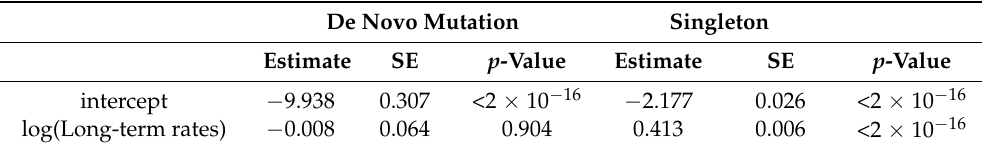
Table 1. Negative binomial regression of numbers of human de-novo mutations and singletons on the me- dian branch length of the mammalian gene trees. The regression model is log ( E [ counts ] / ( gene length )) = α + β log ( median branch length ) : E [ counts ] / ( gene length ) = e α ( long − term rates ) β . De Novo Mutation Singleton Estimate SE p -Value Estimate SE p -Value intercept − 9.938 0.307 <2 × 10 − 16 log(Long-term rates) −